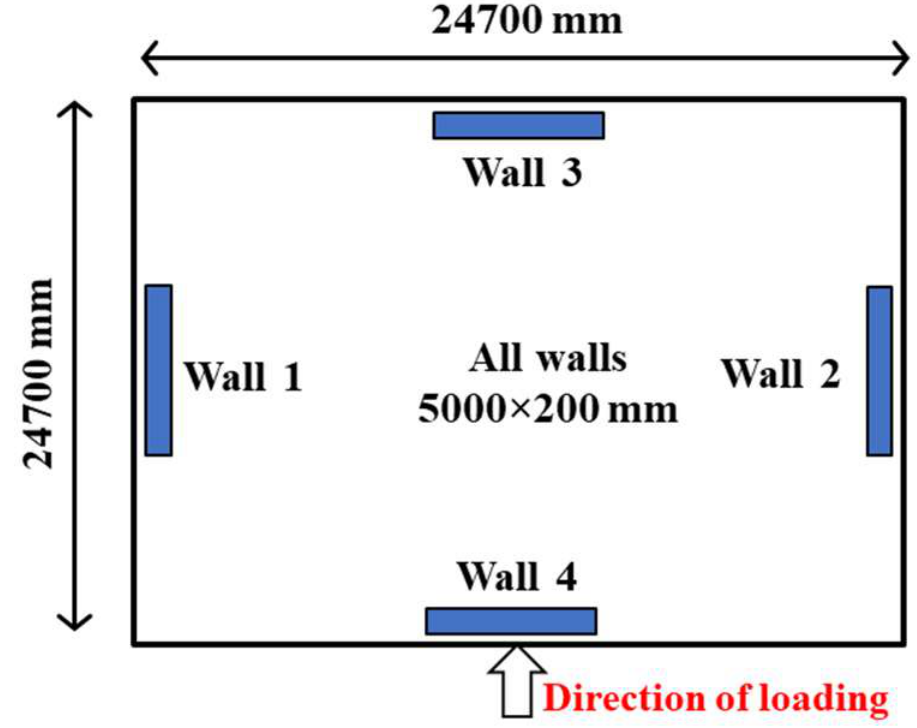
Figure 10. CSB 1 was modified with rectangular walls (building height, H = 19.3 m). The mass and the storey height of the building were kept unchanged. The rectan- gular walls, which were 5000 × 200 mm in dimensions, were built of 40 MPa concrete ( E c = 32,800 MPa) and 1% of N20 vertical reinforcements ( f sy = 550 MPa and f su = 660 MPa). The axial load ratio in each wall was equal to 0.1. By use of Equations (3)–(13), the force and displacement of the structure at first yield, true yield, and ultimate points are calculated as presented